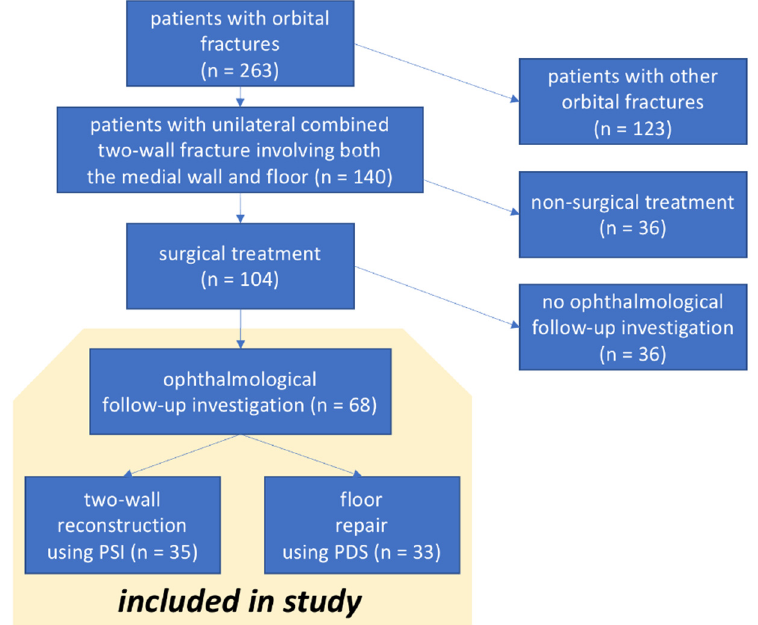
Figure 1. Composition of study group.